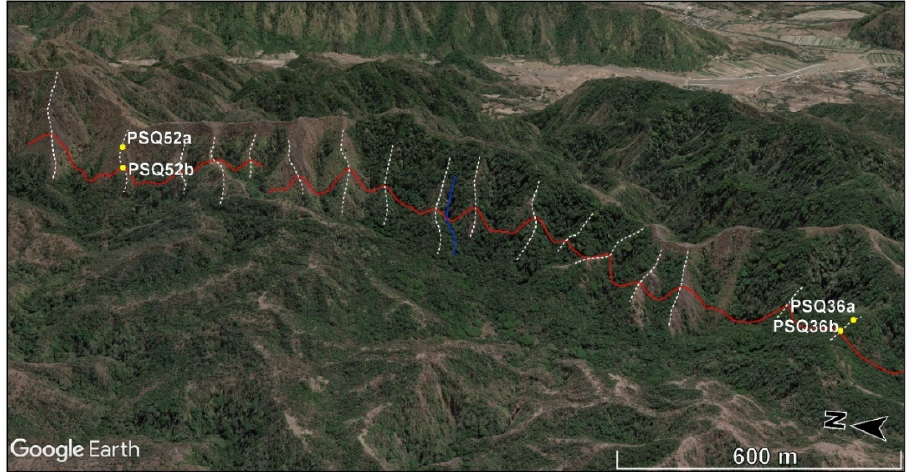
Figure 12. Google Earth perspective view of the middle portion of the Bacarra-Burgos segment (from 13 to 15 km, east of the Pasuquin-Burgos area) displaying elevated V/H values, which belongs to the part of the fault zone where it bends from a NE to NNE orientation. Both sinistrally and dextrally offset spurs are observed along this stretch. Location of this Google Earth perspective view is indicated by a black square in Figure 10.